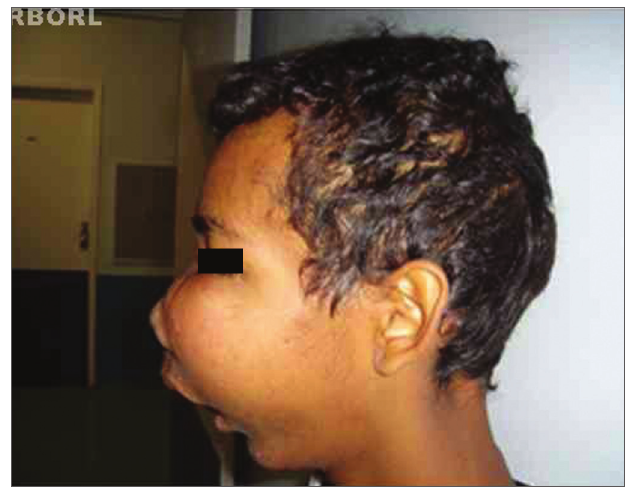
Figura 1. Ameloblastoma de maxila – recorrência.